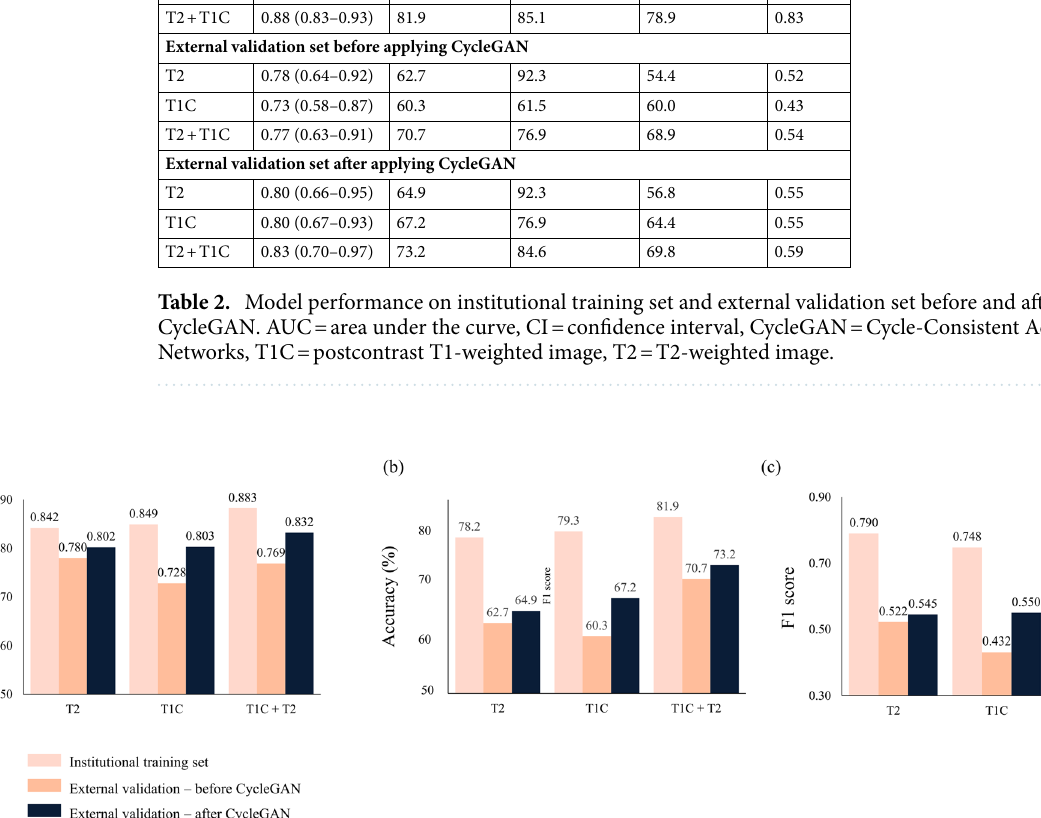
Figure 3. Radiomics model performance on the ( a ) AUCs, ( b ) accuracies, and ( b ) F1 scores of the radiomics model in the institutional training set and external validation set before and after applying CycleGAN. AUCs = areas under the curve, CycleGAN = Cycle-Consistent Adversarial Networks, T1C = postcontrast T1-weighted image, T2 = T2-weighted image.